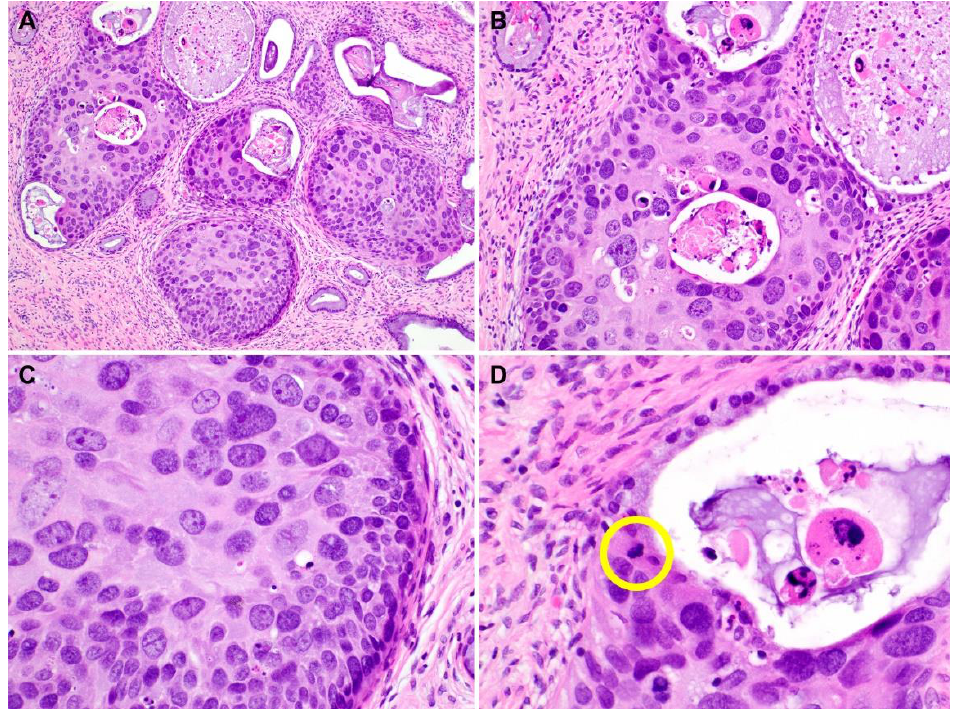
Figure 3. Histological features of pleomorphic high-grade squamous intraepithelial lesion (PHSIL) involving the endocervical glands. ( A ) PHSIL involves multiple endocervical glands. ( B ) The diameter of pleomorphic nuclei is more than five times larger than the basal cells and the adjacent normal endocervical glandular epithelium. ( C ) The nuclei display severe pleomorphism and hyperchromasia. Degenerative-appearing chromatin pattern is not evident. ( D ) An admixture of mucin and necrotic and parakeratotic cellular debris is noted within the lumen. A mitotic figure is detected (a yellow circle). Hematoxylin and eosin staining. Original magnification: ( A ) = 100×, ( B ) = 200×, ( C,D ) = 600×.